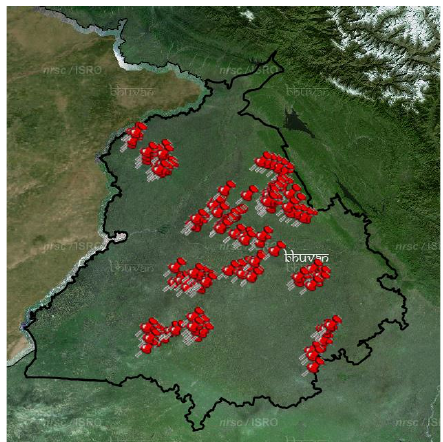
Figure 3. Example of Ground truth points for Punjab state, collected during 1-31 st December 2017, available on Bhuvan